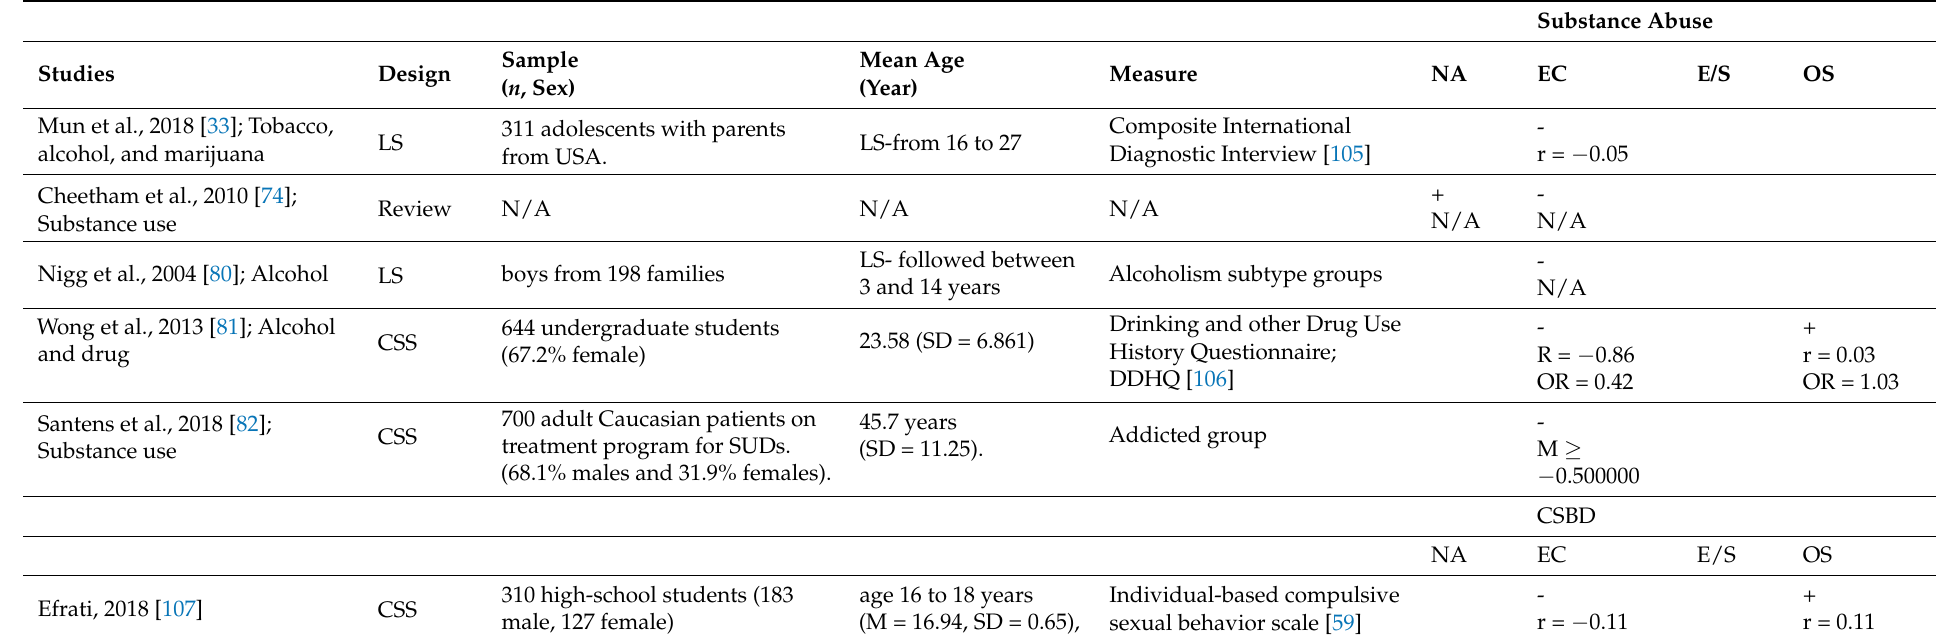
Table 3. Temperament traits (ATQ; Adult Temperament Questionnaire) on substance abuse and